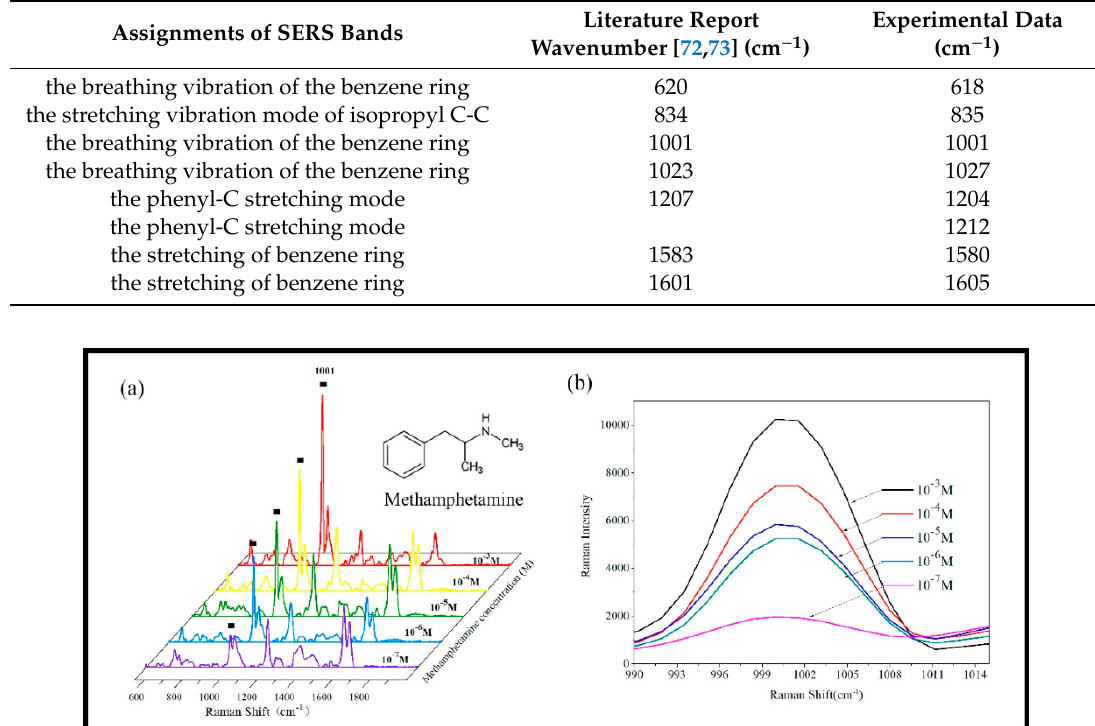
Table 3. Assignments of SERS bands of methamphetamine.